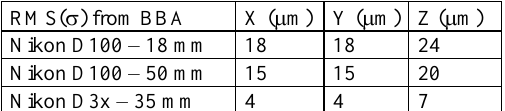
Table 1 – Precision estimates from the BBA: RMS of the coordinate’s standard deviations of the points on the implants, with different combination camera-lens; results refer to a block with 16 images and camera focused at the shortest